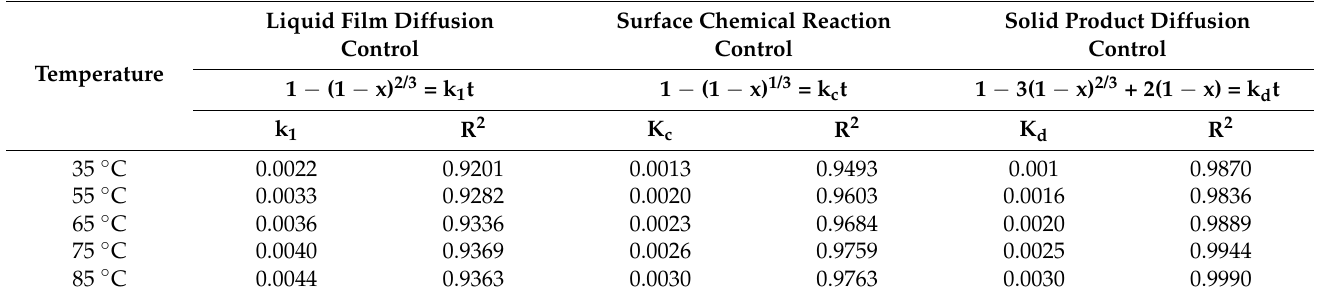
Table 6. Nickel leaching kinetics parameters of different models during the reaction time.